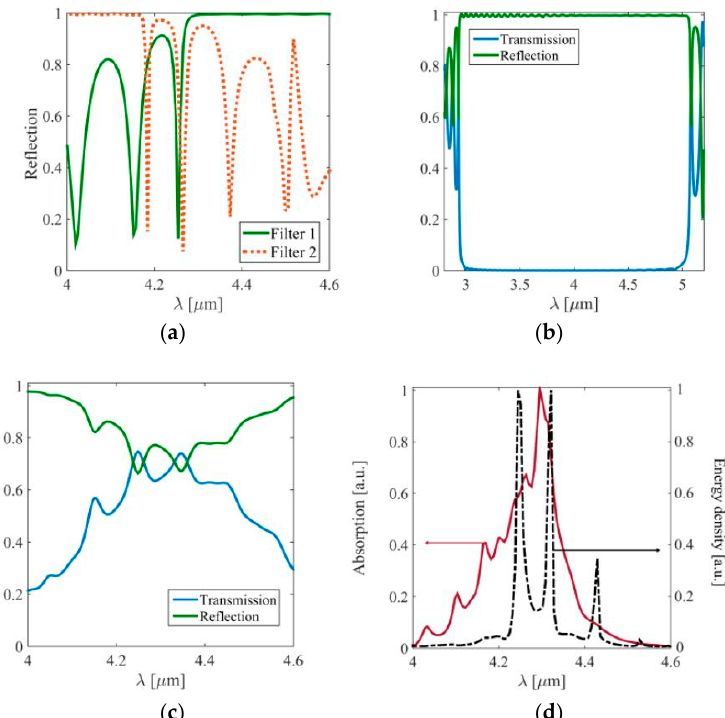
Figure 2. Optical response of the individual sections of the structure: ( a ) Filters 1 and 2; ( b ) Mirror; ( c ) Matching section; ( d ) Response of the whole structure for an excitation of the fundamental slab mode in the slab region; Red thick line corresponds to the absorption of the system when filter 1 is undoped and black dashed line shows the energy density when all components are